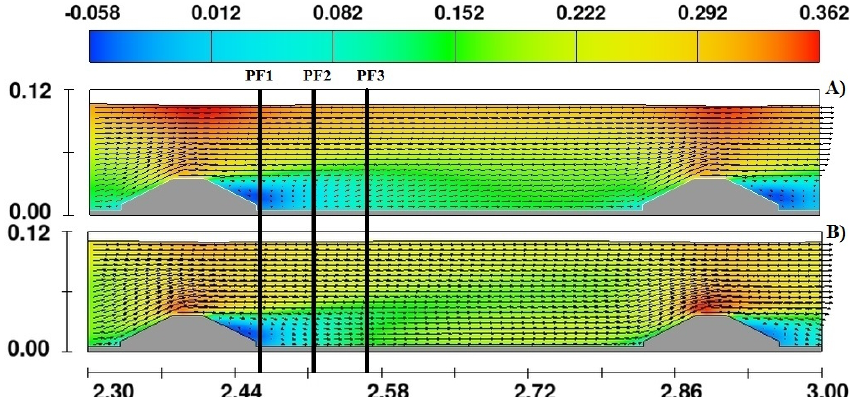
Figure 9. Streamwise velocity contours and vectors (m s − 1 ) in the XZ plane (dim in meters). Location of profiles (PF1 = 2.45; PF2 = 2.50 and PF3 = 2.55 m from origin) for ( A ) RNG Model and ( B ) k-epsilon